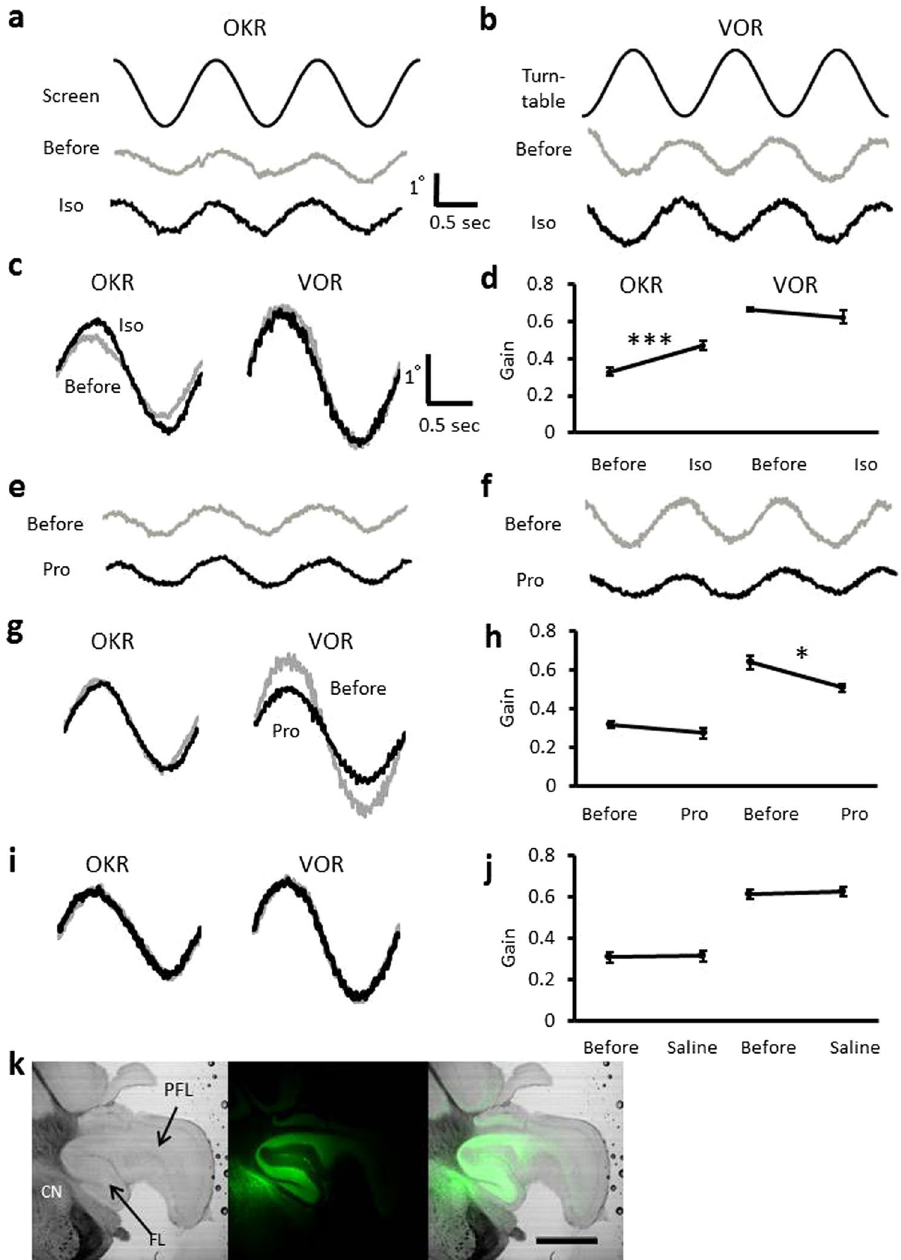
Figure 1. Effects of β -adrenergic agonist isoproterenol or antagonist propranolol on OKR and VOR. ( a , b ), Representative eye position traces during OKR or VOR before and after administration of isoproterenol (Iso). The command signal corresponding to the position of screen ( a ) or turntable ( b ) is also presented (top). ( c ) Averaged (10 cycles) traces of eye position before (grey) and after (black) isoproterenol administration ( d ) Gain changes of OKR and VOR by isoproterenol administration. ( e,f ) Eye position traces during OKR ( e ) and VOR ( f ) before and after administration of propranolol. ( g ) Averaged eye position traces. ( h ) Gain changes of OKR and VOR caused by propranolol administration. ( i ) Averaged traces of eye position before and after saline administration. ( j ) Gains of OKR and VOR before and after administration of saline. Error bars indicate SEM. * p < 0.05, *** p < 0.001, paired Student’s t-test. ( k ) Photographs of the flocculus injected with acriflavine (green). FL, flocculus; PFL, para-flocculus; CN, cochlear nucleus. Scale bar indicates 1